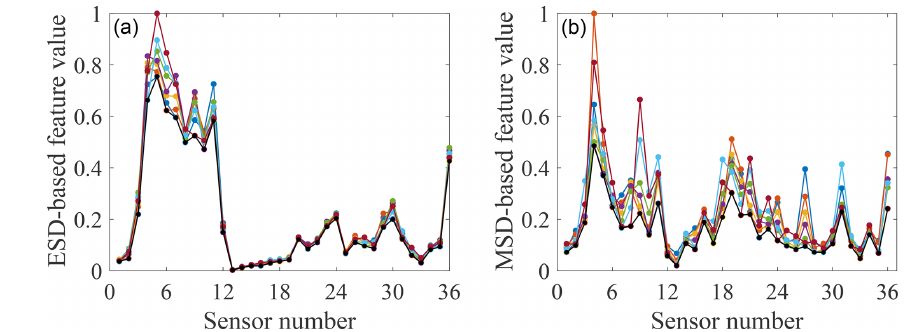
Figure 9. Feature-bagging results based on ESD (a) and MSD (b) for the damage case with M1 and M2 added.